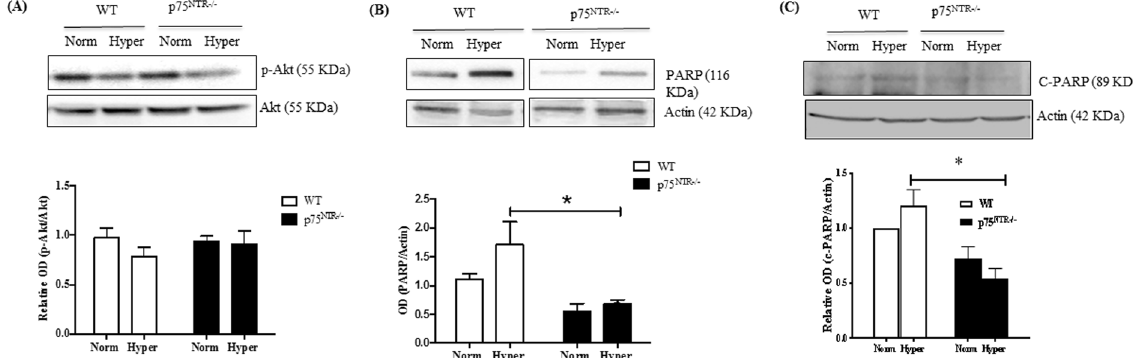
Figure 3. Deletion of p75 NTR preserved survival signal and attenuated hyperoxia-mediated apoptosis. ( A ) Representative Western blotting and bar graph showing modest decrease in Akt activation (Y308) in response to hyperoxia at p12 retinal lysates of WT and p75 NTR − / − mice (n = 5–7). ( B ) Representative Western blotting and bar graph of total PARP expression in p12 retinal lysates of WT and p75 NTR − / − mice ( * significant using two-way ANOVA, p < 0.05, n = 7). ( C ) Representative Western blotting and bar graph of cleaved PARP expression in p12 retinal lysates of WT and p75 NTR − / − mice ( * significant using two-way ANOVA, p < 0.05, n = 4–6).